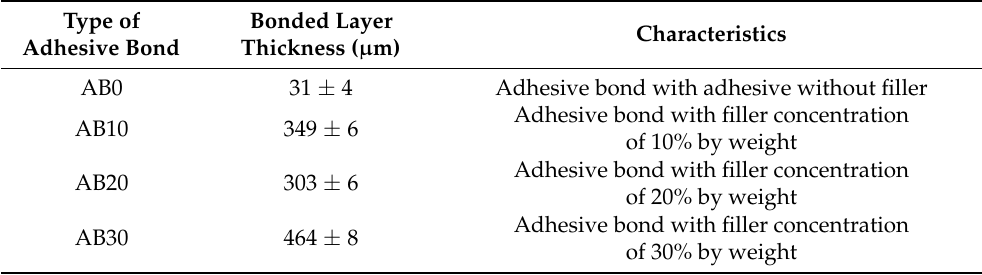
Table 2. Type of adhesive bonds and their